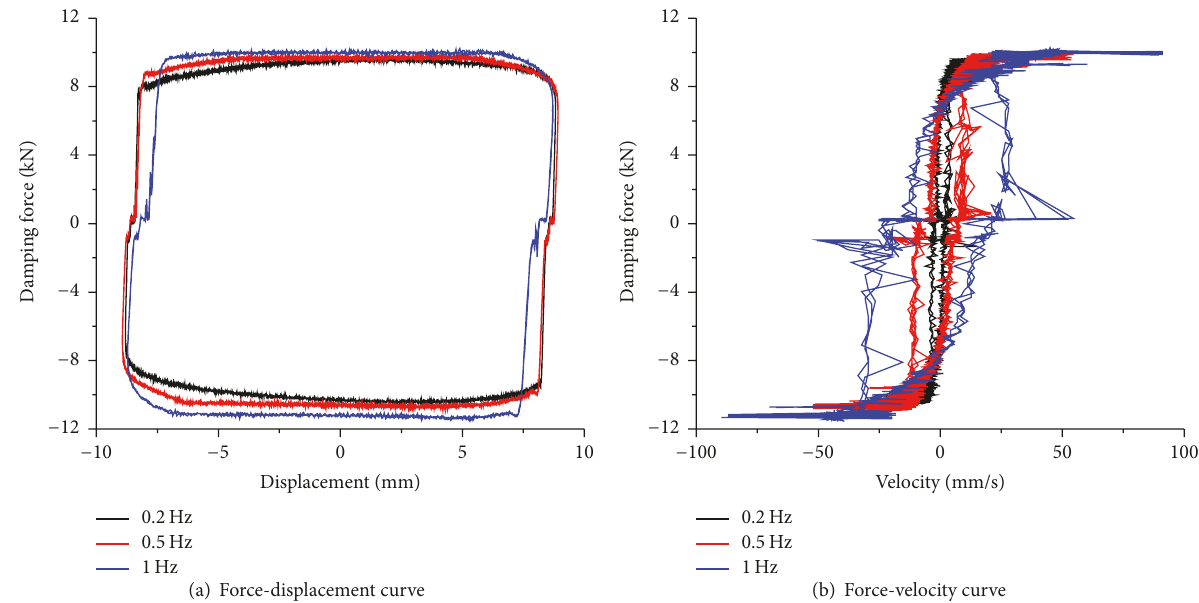
Figure 4: Force-displacement and force-velocity hysteresis curves for different